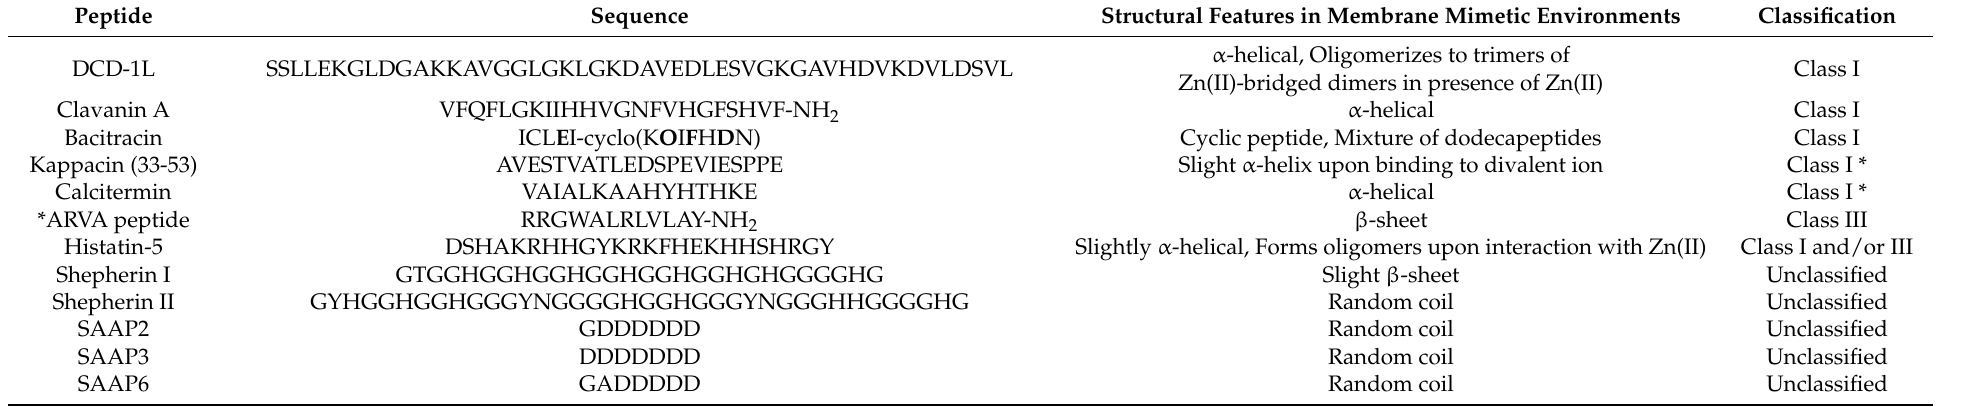
Table 1. Each of the metalloAMPs we focused on in the different families discussed are organized in this table defining their sequence, structural features when within environments that mimic membranes, and their Zn-AMP classification. The sequences that included D-amino acids are designated by their one-letter code being in bold, and the cyclized portion designated within the sequence. Peptides with amidated C-terminals are indicated with an amine included at the end of the sequence. Classifications that need further research to achieve full designation are indicated with an